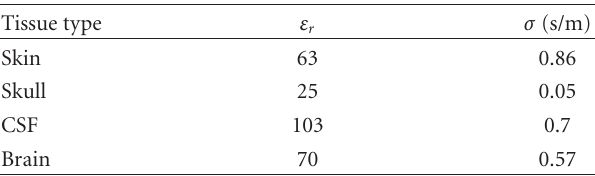
Table 1: The dielectric and conductivity of tissues inside a human head at 128